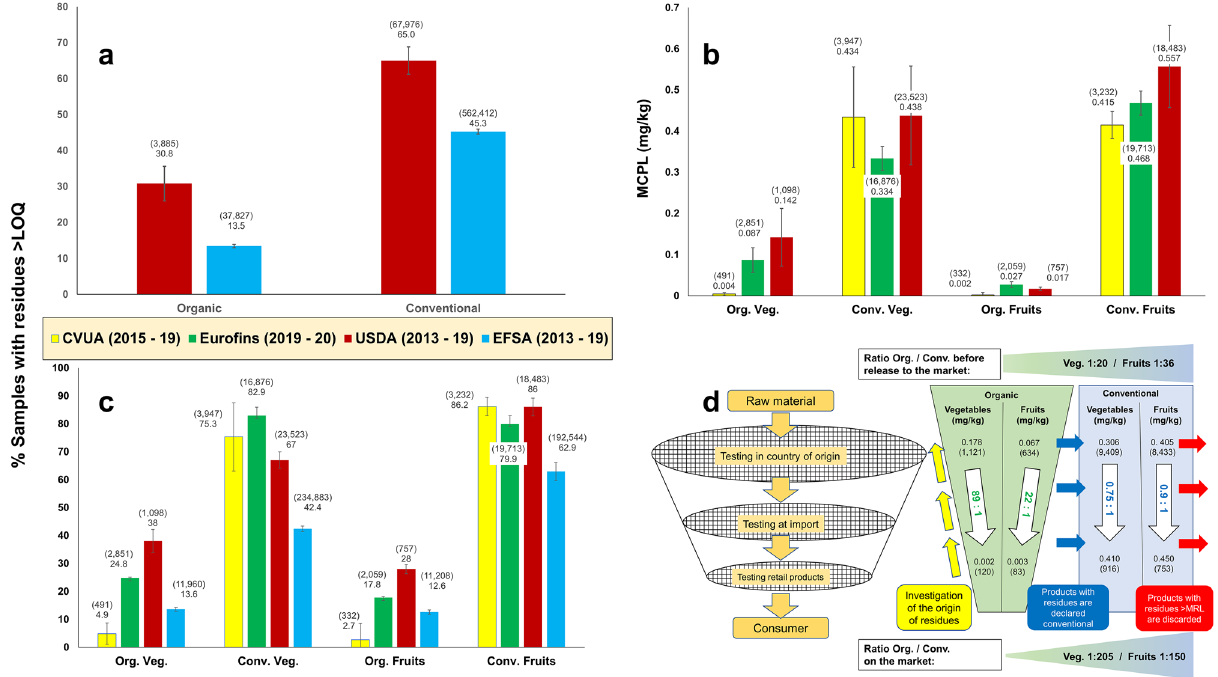
Figure 1. Pesticide residues in conventional and organic food in tests conducted by four organisations: EFSA (European Food Safety Authority) collects official data from all EU member states 3 , CVUA from one federal state in Germany 4 , USDA from government laboratories across the U.S. 5 , while Eurofins is a commercial laboratory in Germany. Figures in brackets represent the number of samples. The legend is valid for ( a ), ( b ) and ( c ). In order to increase the number of samples (represented in brackets) and thus their representativeness, figures from several years were grouped together, as available from each organisation. Black bars symbolise standard errors across years. ( a ) Shows the percentage of samples with residues above the limit of quantification (LOQ), for all types of food (available from two organisations only). ( b ) Represents the mean cumulative pesticide load (MCPL) for fruits and vegetables (available from three organisations). ( c ) Similar to ( a ), but for fresh fruits and vegetables only (CVUA uses “above 0.01 mg/kg” instead of LOQ, but this is identical for most substances). The same datasets were used for ( b ) and ( c ). ( d ) Multi-layer sieving model for residue testing of fruits and vegetables in 2019, at different points of the organic supply chain. The data above the white arrows are from the commercial laboratory Eurofins, and mostly represent the situation before products are released to the market, while the figures below the white arrows are from CVUA, representing the situation on the market (both wholesale and retail). Ratios from "before market" to "on market" are shown in the white arrows. In this process, the MCPL remains in the same range for conventional products (blue rectangle to the right), while it is reduced massively for organic products (green trapezium in the centre). As a result of this sieving mechanism, residues in samples from the market are 150 and more times lower in organic than in conventional produce (trapezium at the bottom). This shows that the process represented by the blue arrows works fairly well—which is not always the case for the investigation of the origin of such residues, symbolised by the yellow